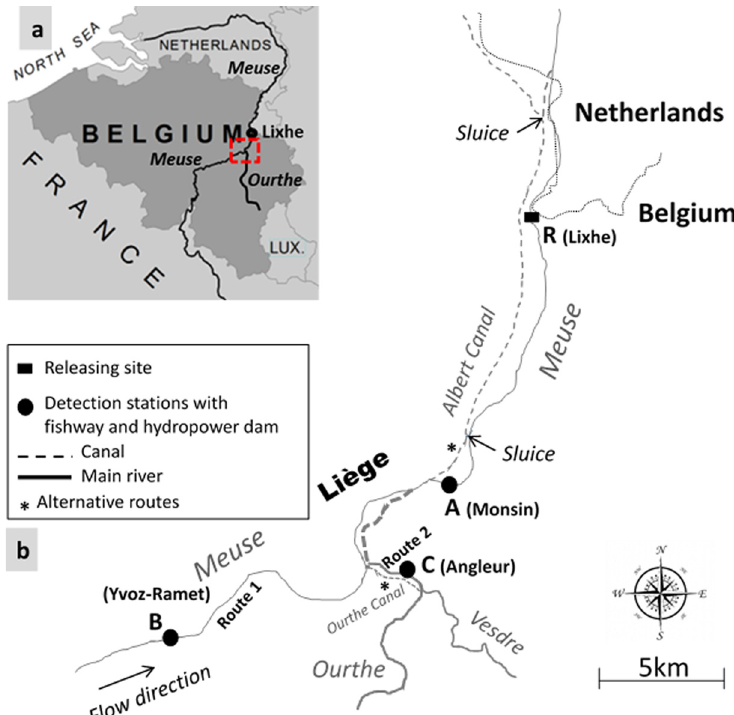
Fig. 1. Map of the study area in the International and Belgian Meuse River basins (a), and location of the catch and release site in the Meuse (at R – Lixhe), the fi rst upstream detection station in the Meuse ( A – Monsin), the upstream migration route 1 in the upper Meuse ( B – Yvoz-Ramet), the upstream migration route 2 in the Ourthe tributary ( C – Angleur), and the alternative migration routes of yellow-phase eels (the navigable canals of Albert and Ourthe, and the non-navigable Liège Canal)